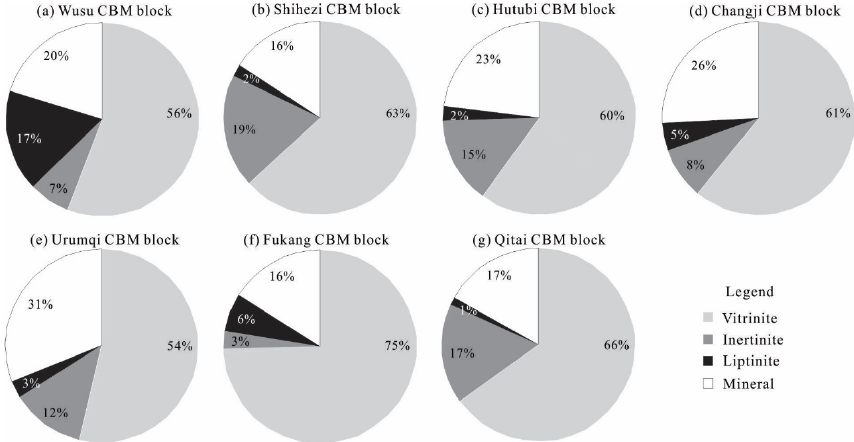
Figure 2. Pie charts illustrating coal mass compositions in the Middle Jurassic coals from the southern Junggar Coalfield. ( a – g ) represent the Wusu, Shihezi, Hutubi, Changji, Urumqi, Fukang, and Qitai CBM blocks, respectively. Each CBM block has a ~20 vol % of mineral matter content. Liptinite group: This group is defined by a darker color in comparison to other maceral groups and multifarious fluorescence in ultraviolet light. In the studied Middle Jurassic coals, the most predominant submacerals are structured liptinite macerals, including cutinite (avg. 5.1 vol %), sporinite, resinite, and liptodetrinite. However, unstructured liptinites (i.e., fluorinite) were occasionally found under the microscope (Table 1).